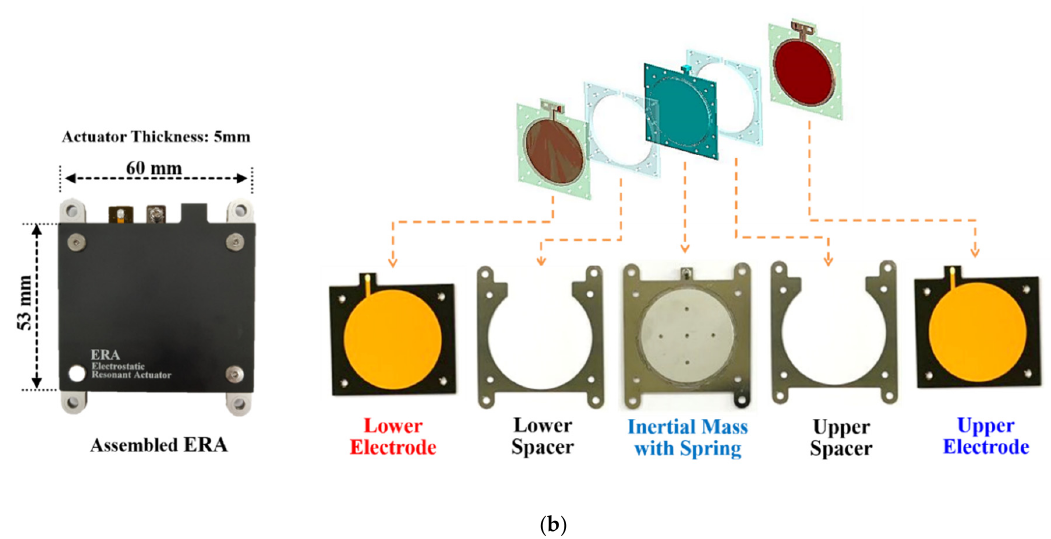
Figure 3. ( a ) FEM simulation to determine the spring stiffness; ( b ) fabricated ERA module separated by part.